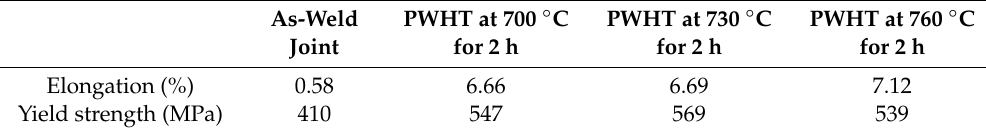
Table 3. Elongation and yield strength of the welded joints without and with PWHT.